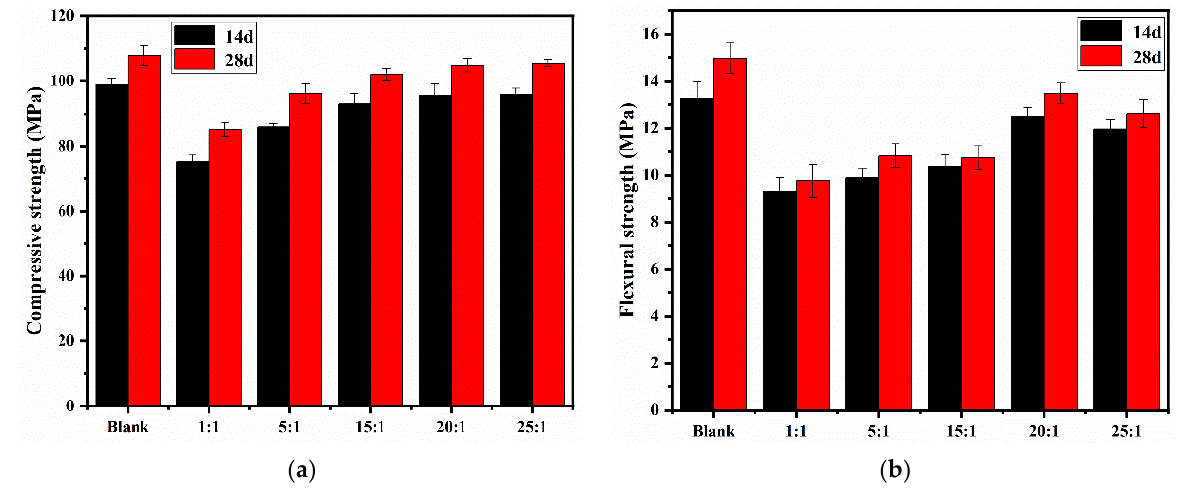
Figure 9. Mechanical strengths of cement mortars with or without PBA-g-PDMAEMA: ( a ) compressive strength; ( b ) flexural strength.